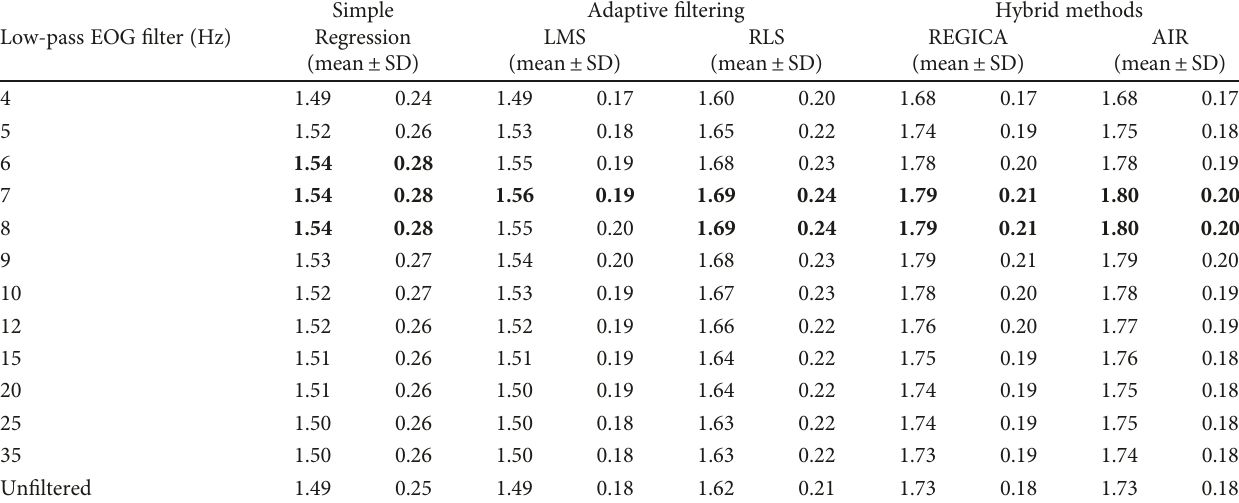
Table 4: Mutual information scores (mean of all EEG channels and mean of all simulated subjects).